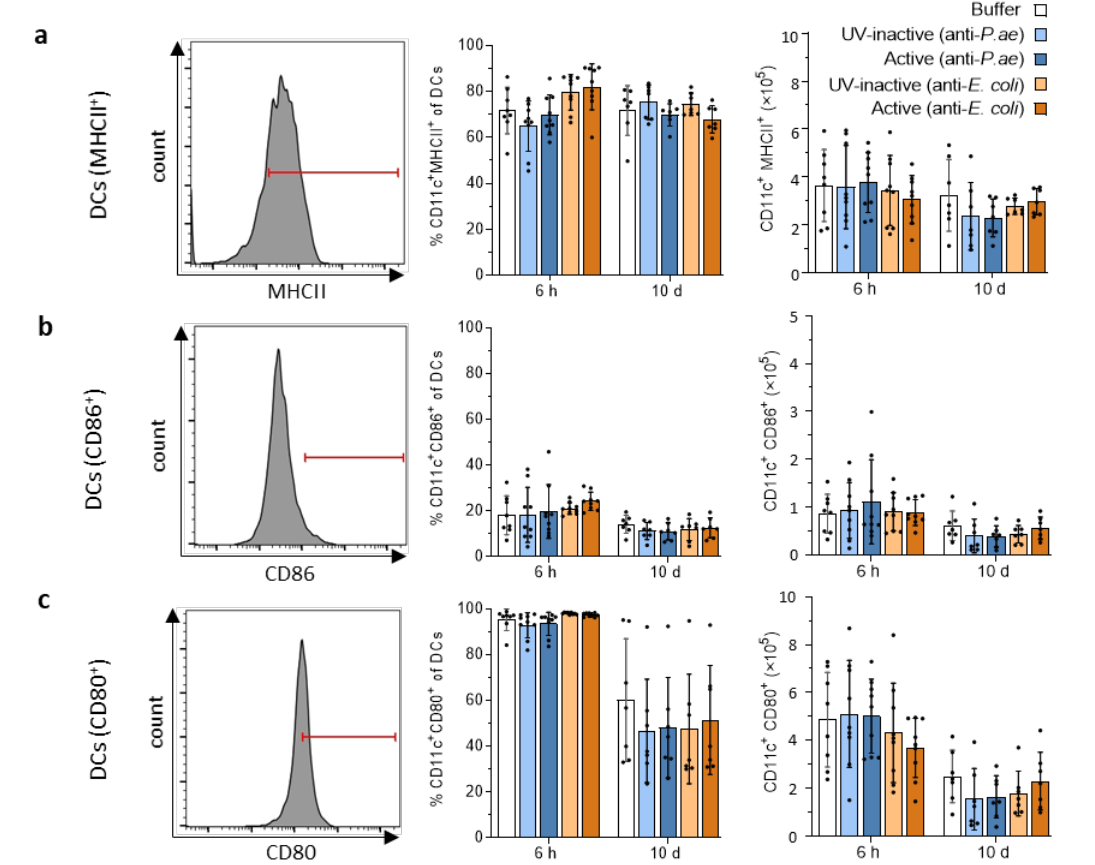
Figure 4. Splenic dendritic cells are not activated in response to phage cocktail treatment. Flow cytometric analysis of markers of antigen presenting cells (APC) activation ( a ) MHCII, ( b ) CD86 and ( c ) CD80 on DCs from the spleen. Shown are representative histograms (left) and bar graphs depicting the percentage of cells (middle) positive for indicated marker (MHCII, CD86, CD80) or total number of cells positive for indicated marker (right). Results are shown as mean ± SD, as determined by 2-way ANOVA with Tukey ’ s multiple comparisons test: n = 7 – 9 mice per group. For full gating strategy see Figure S1. Red lines define positive expression of markers based on fluorescence minus one (FMO) staining. PMNs, polymorphonuclear neutrophils; DCs, dendritic cells.